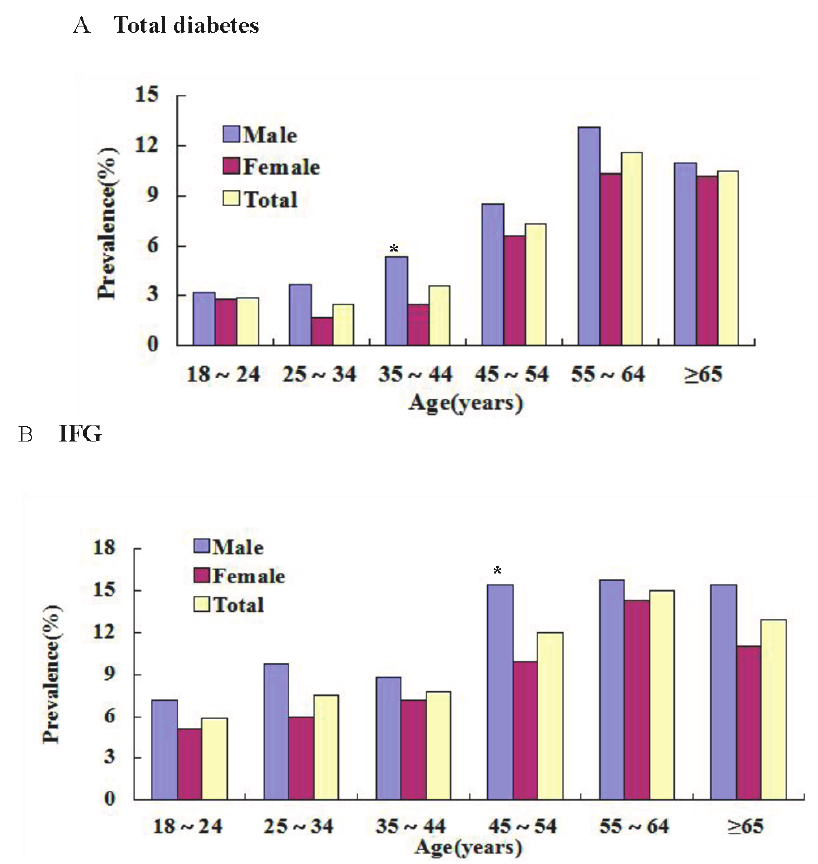
* Male vs . Female, p < 0.05 with chi-square